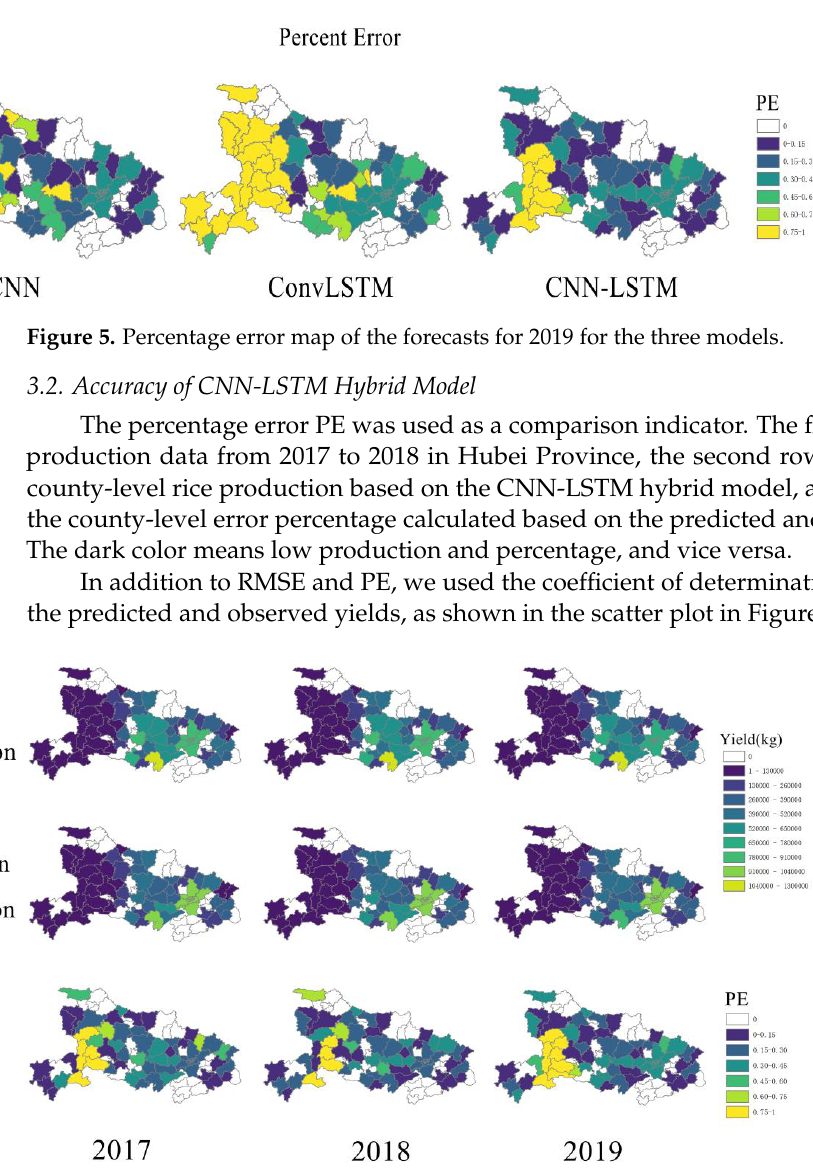
from 2017 to 2018.